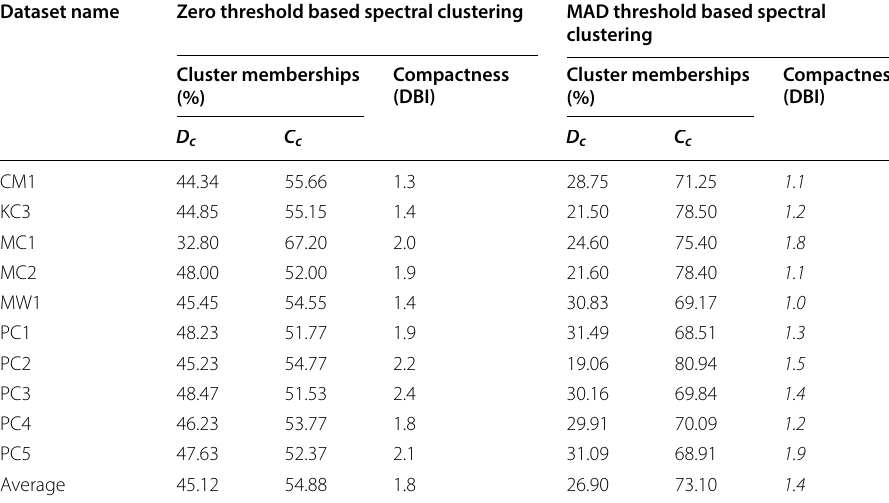
D c is the predicted defective cluster; C c is the predicted clean cluster The italicized values indicate the better performance